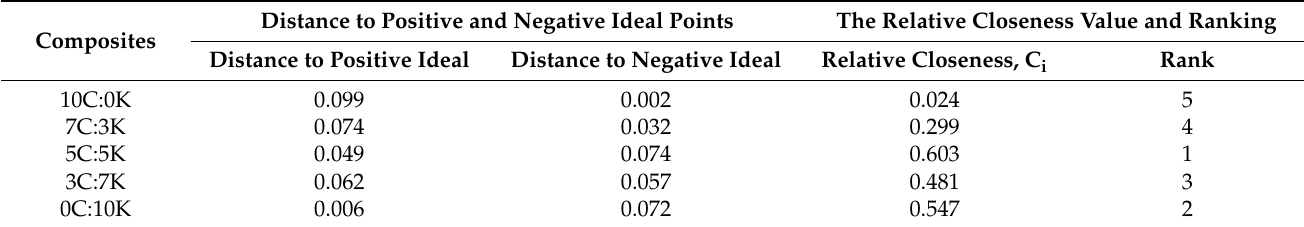
Table 10. Distance to positive, negative ideal points, and the relative closeness value and ranking.